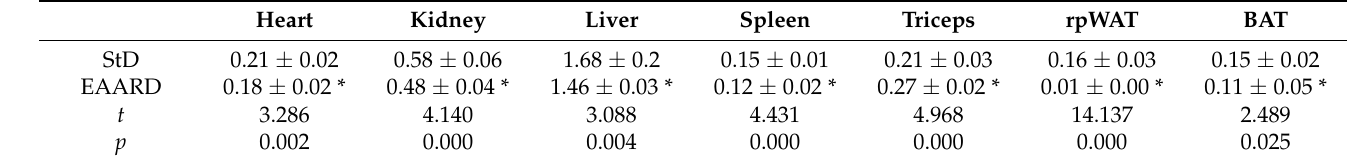
Table 3. Organ weight (grams, mean ± sd) at the end of treatment.